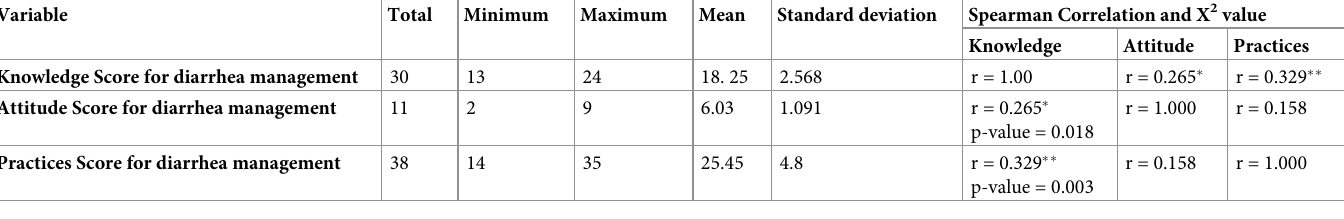
Table 10. Descriptive statistics for KAPs of CHWs regarding the management of childhood diarrhea.